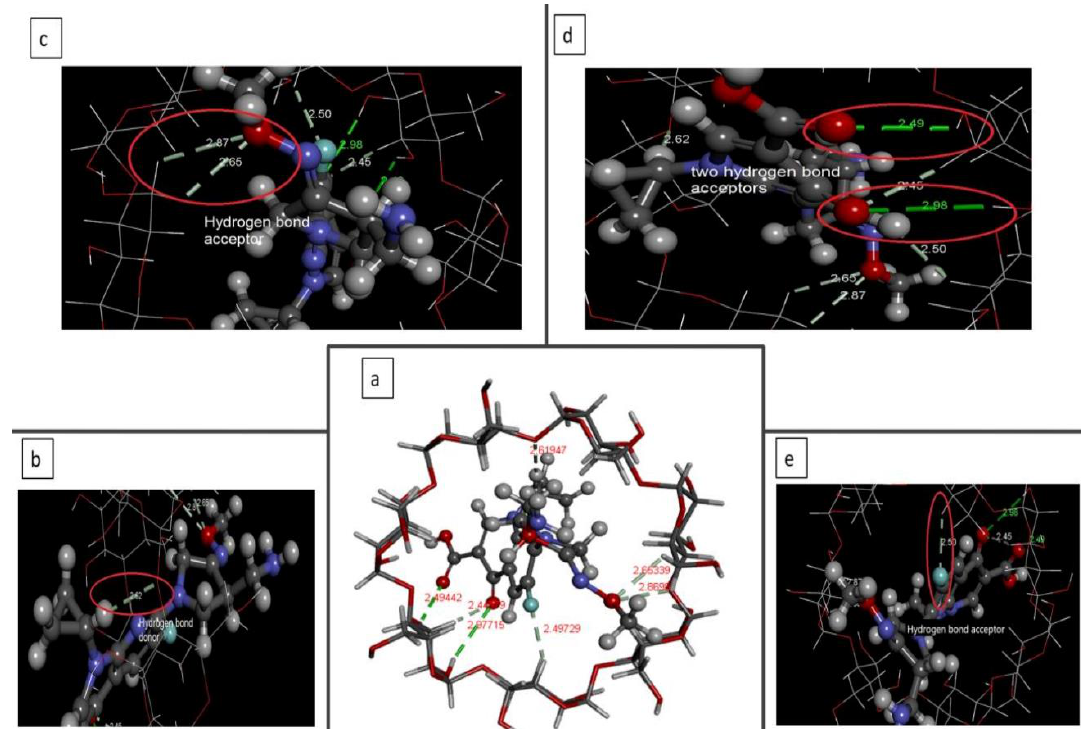
Figure 4. ( a ) Proposed 3D structure of the GEMI–β-CD inclusion complex; ( b ) hydrogen bond donor; ( c ) hydrogen bond acceptor; ( d ) two hydrogen bond acceptors and ( e ) hydrogen bond acceptor. The GEMI structure is presented as ball and sticks and the βCD structure is presented as sticks only.